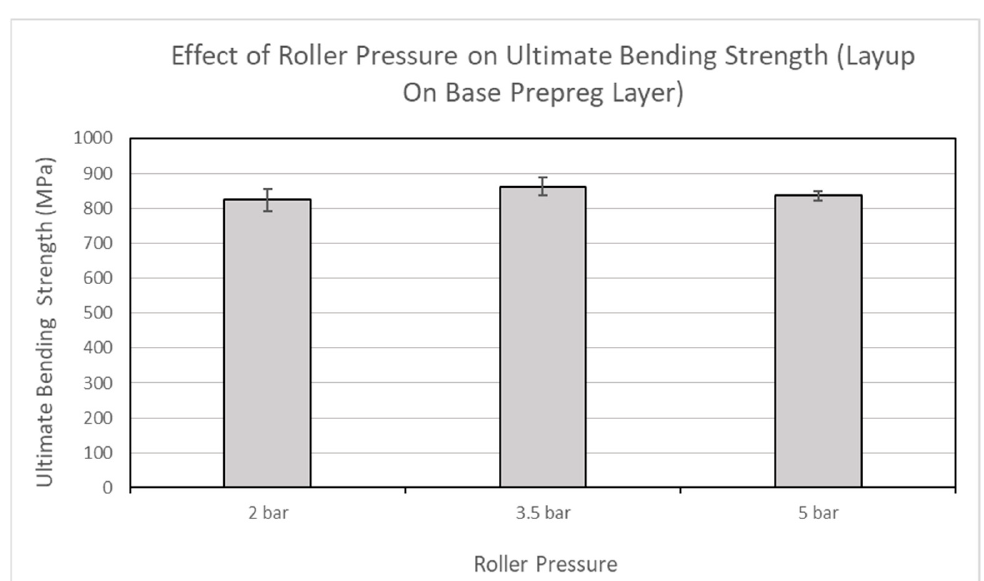
Figure 21. Effect of roller pressure and base layer on ultimate bending strength for layups on pre- preg base layer. base layer.